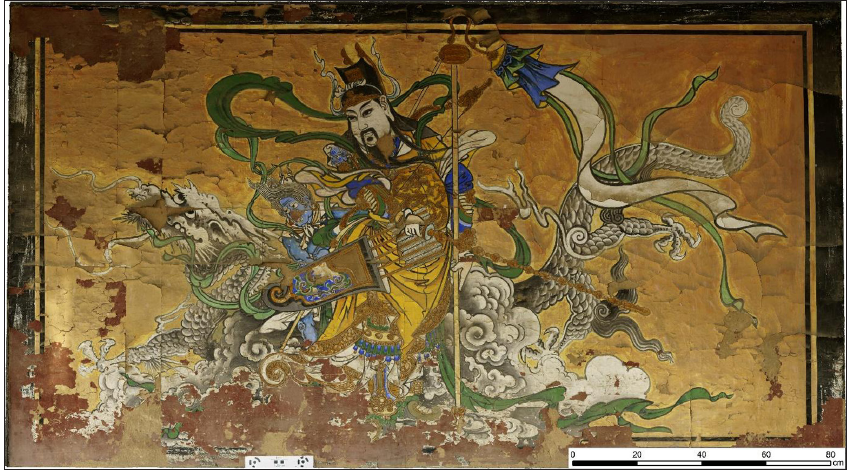
Figure 5: Room 2 Wall 6 in Yangzhongwu Temple, 代县杨忠武祠 (SDDP_DXZL008). Image courtesy of the SDDP